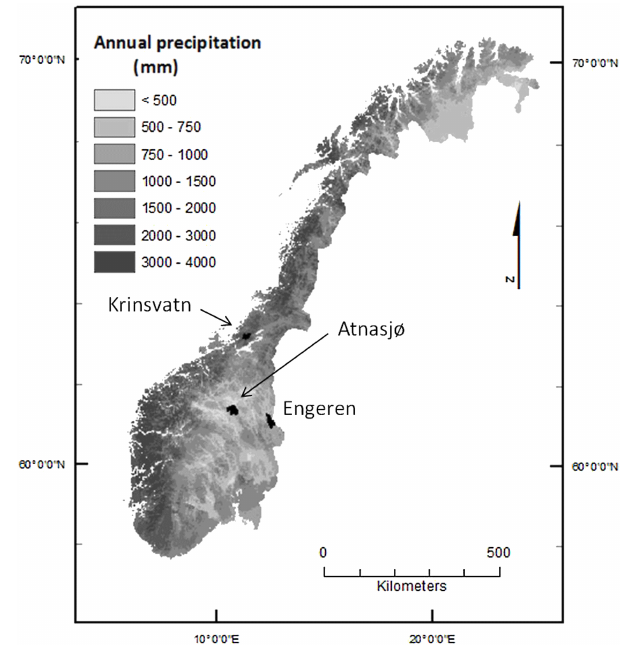
Figure 1. Catchment locations and spatial pattern of average annual rainfall (1961–1990) in